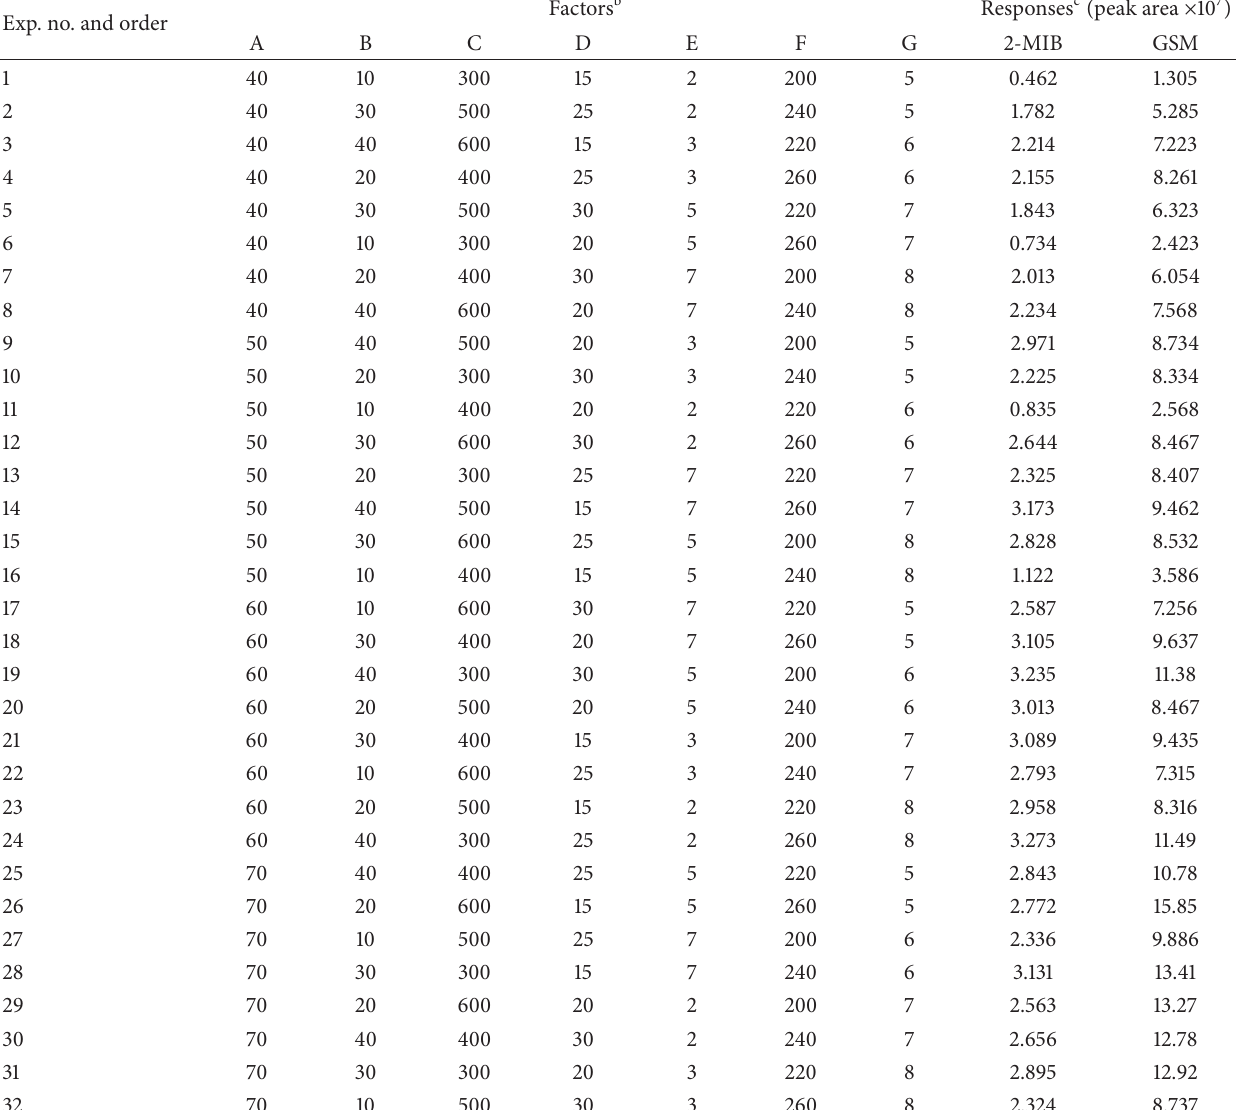
(4 9 ) orthogonal array and the response of the peak area count by GC-MS a . 32